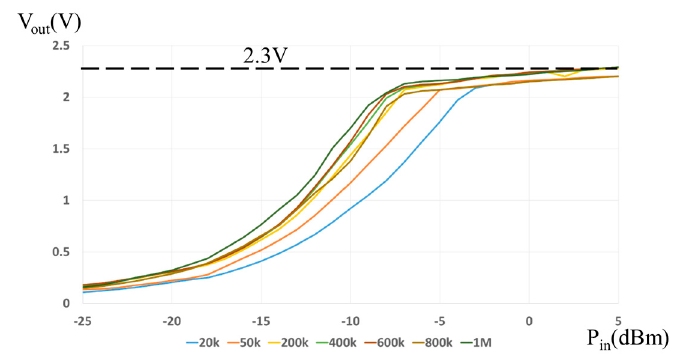
Figure 11. Measurement output of V out under different loading.